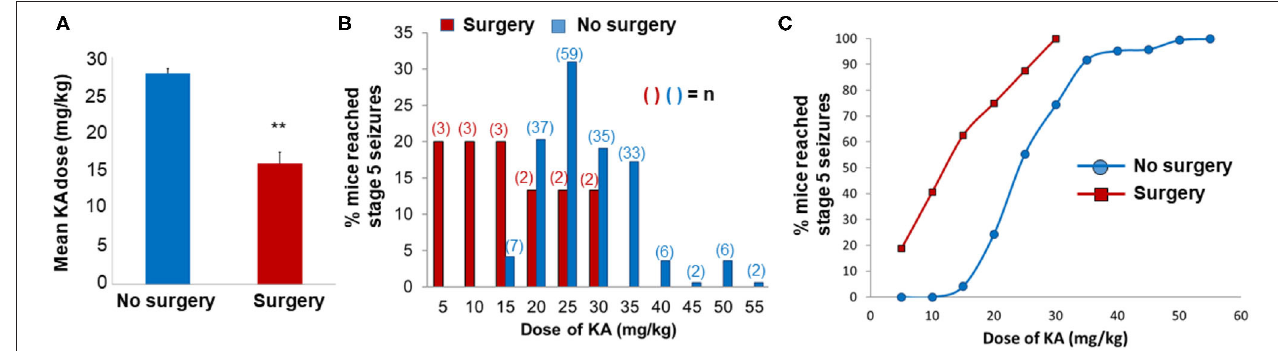
FIGURE 2 | Impact of surgery on seizure threshold in response to kainate (KA). (A,B) The mean (A) and the total (B) KA dose required to induce generalized convulsive seizures (stage 5 on the Racine scale) in C57BL/6J mice that were either implanted with intracerebral electrodes (Surgery, n = 15) or not implanted (no surgery, n = 187). KA was administered 7 days post-surgery. In graph A, the data are expressed as the mean ( ± SEM) KA dose (mg/kg) and compared the groups using a two-sample t -test (** p < 0.01). The data in B are expressed as a percentage of the total number of animals in each group that reached stage 5 seizures at each dose increment. (C) The dose-response data for KA are expressed as a cumulative percentage of the total number of animals in each group.